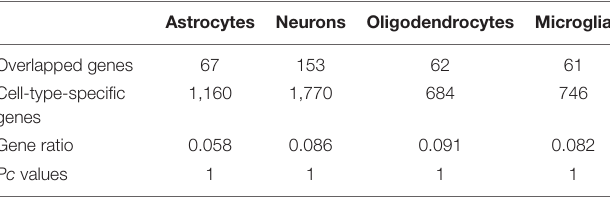
PLS1, the first component of partial least squares regression; Overlapped genes, the number of overlapping genes between PLS1 + genes and cell-type-specific genes; Gene ratio, ratio between the number of overlapping genes and the number of cell-type-specific genes; Pc values, the Bonferroni corrected